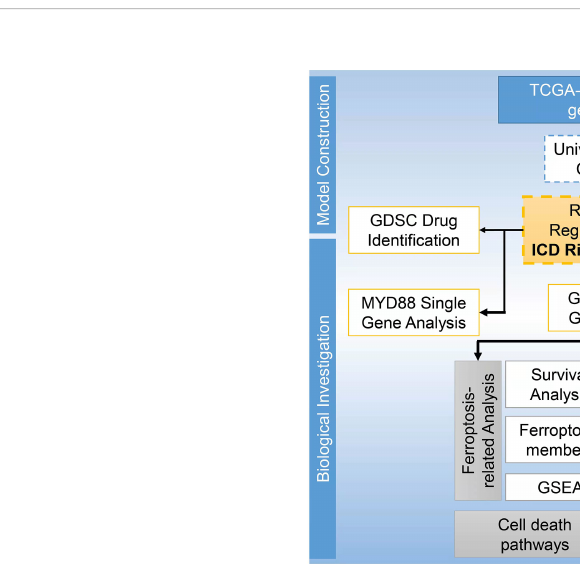
FIGURE 8 Work fl ow to present the study